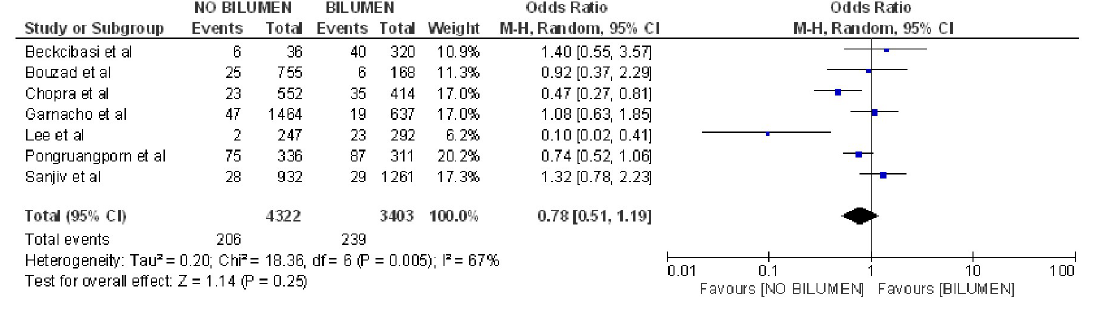
Fig 6. Forest plot of bilumen catheter and CLABSI.